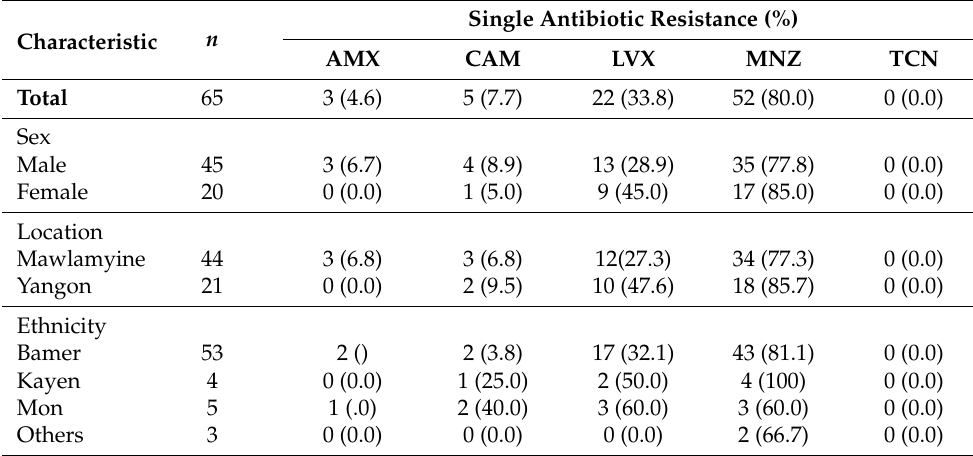
Table 1. Distribution of antibiotic resistance based on basic characteristics.